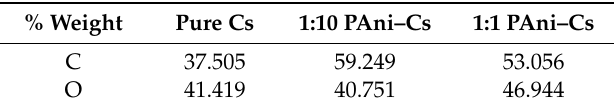
Table 2. Composition of pure chitosan (Cs) and 1:10 and 1:1 polyaniline–chitosan (PAni–Cs) composites obtained using energy-dispersive X-ray spectroscopy (EDX). % Weight Pure Cs 1:10 PAni–Cs 1:1 PAni–Cs